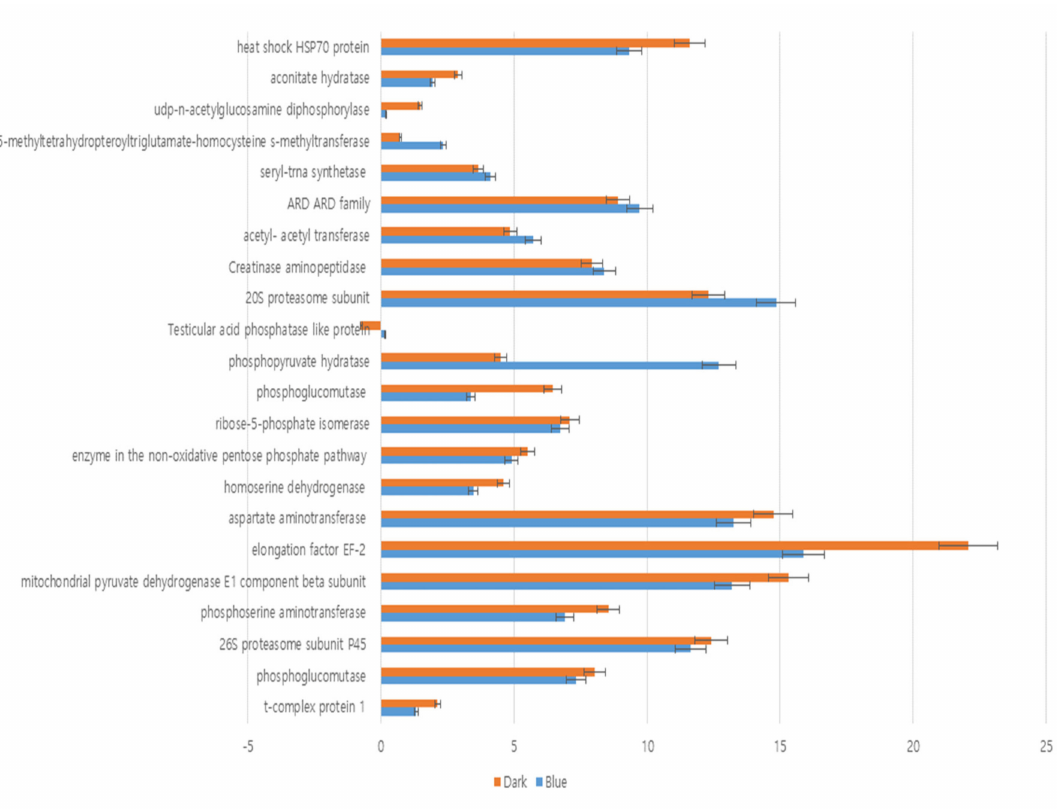
Figure 3. RT-qPCR analysis of 22 proteins in LE fruit body